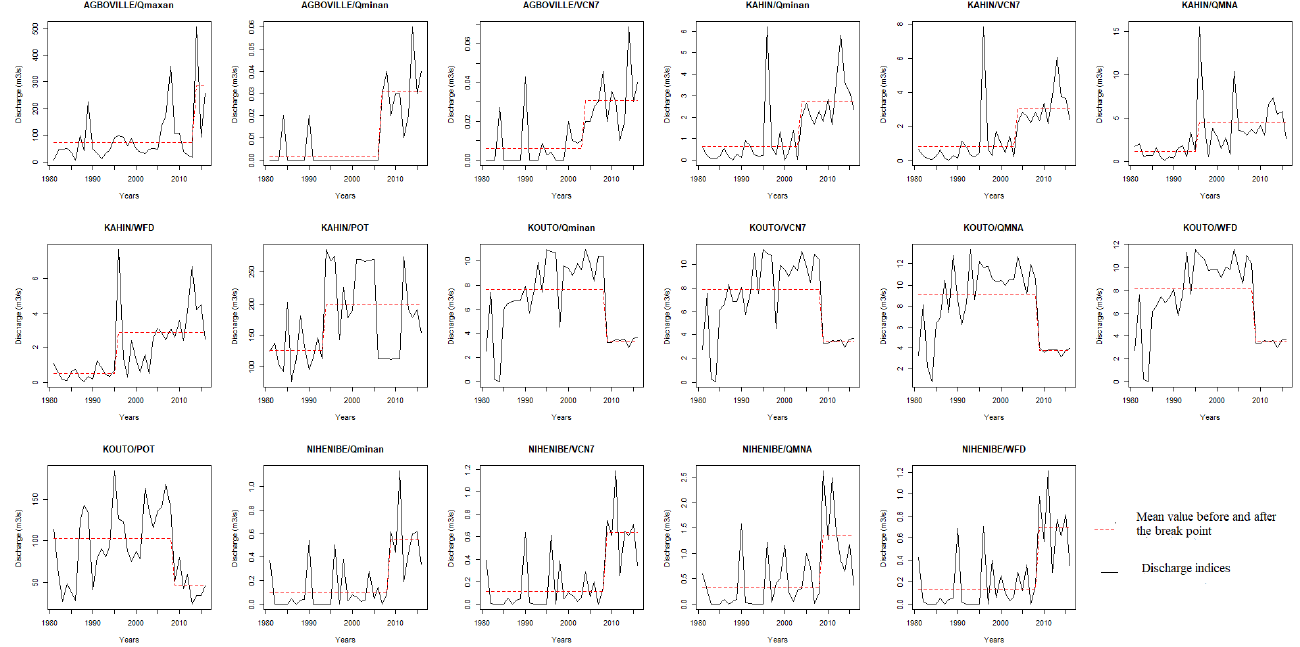
Figure 6. Significant break result for the homogeneous stations .